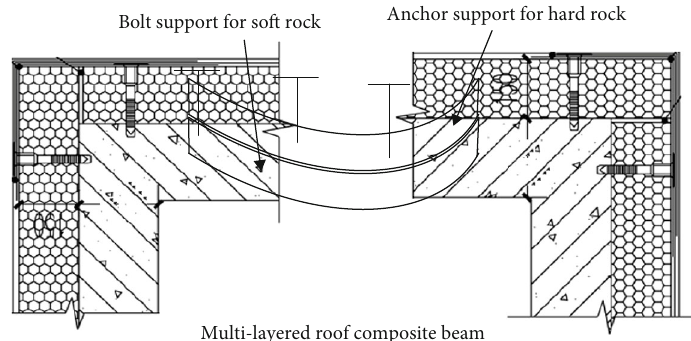
Figure 2: Composite beams with a multilayered roof.